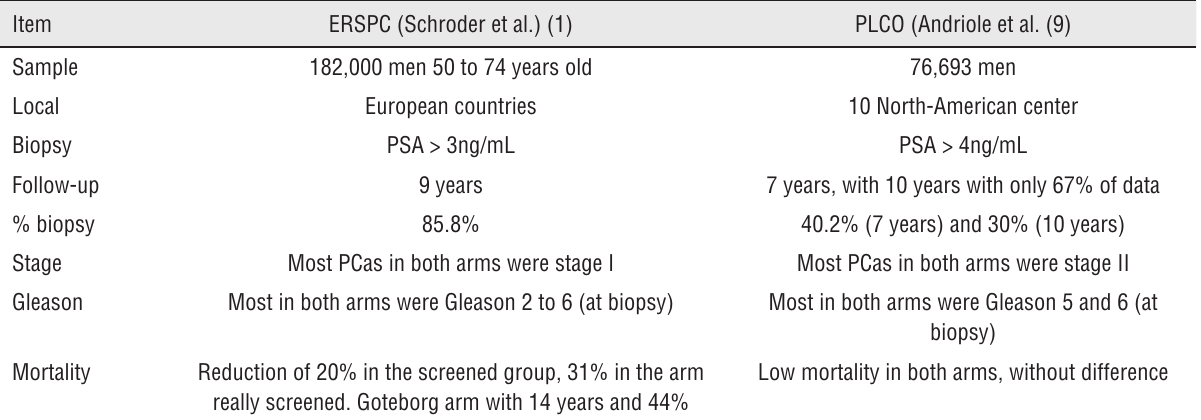
Table 2 - comparison of two major studies of prostate cancer